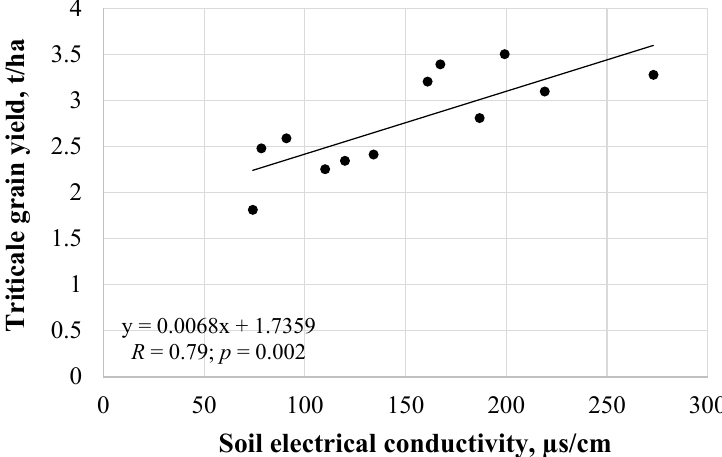
Figure 12. Relationship between soil electrical conductivity (µs/cm) and triticale grain yield (t/ha).